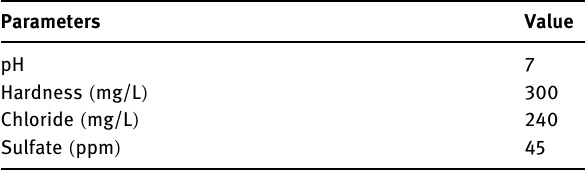
Figure 3: Jute fi ber wrapped around steel bar ( scale in meters )